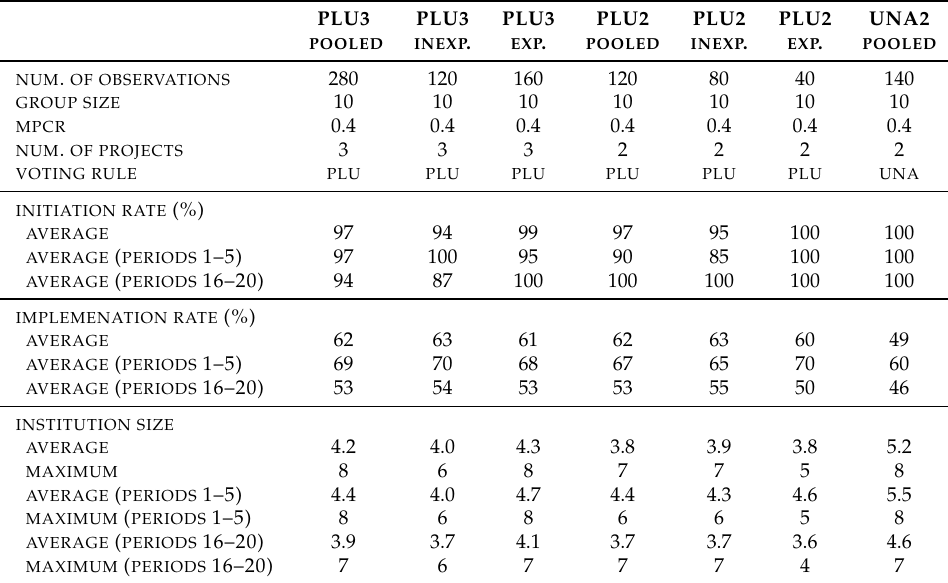
Table A1. Summary of experimental results (part